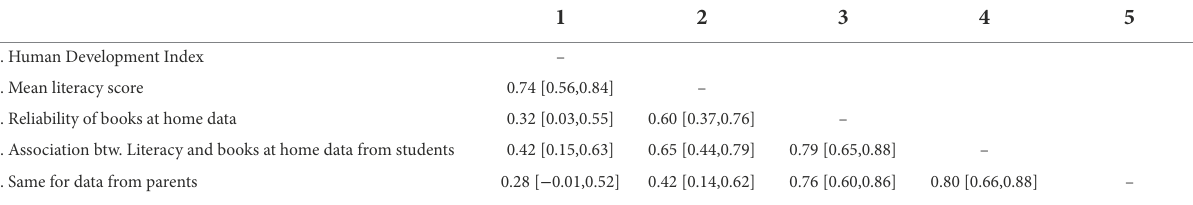
TABLE 1 Country-level